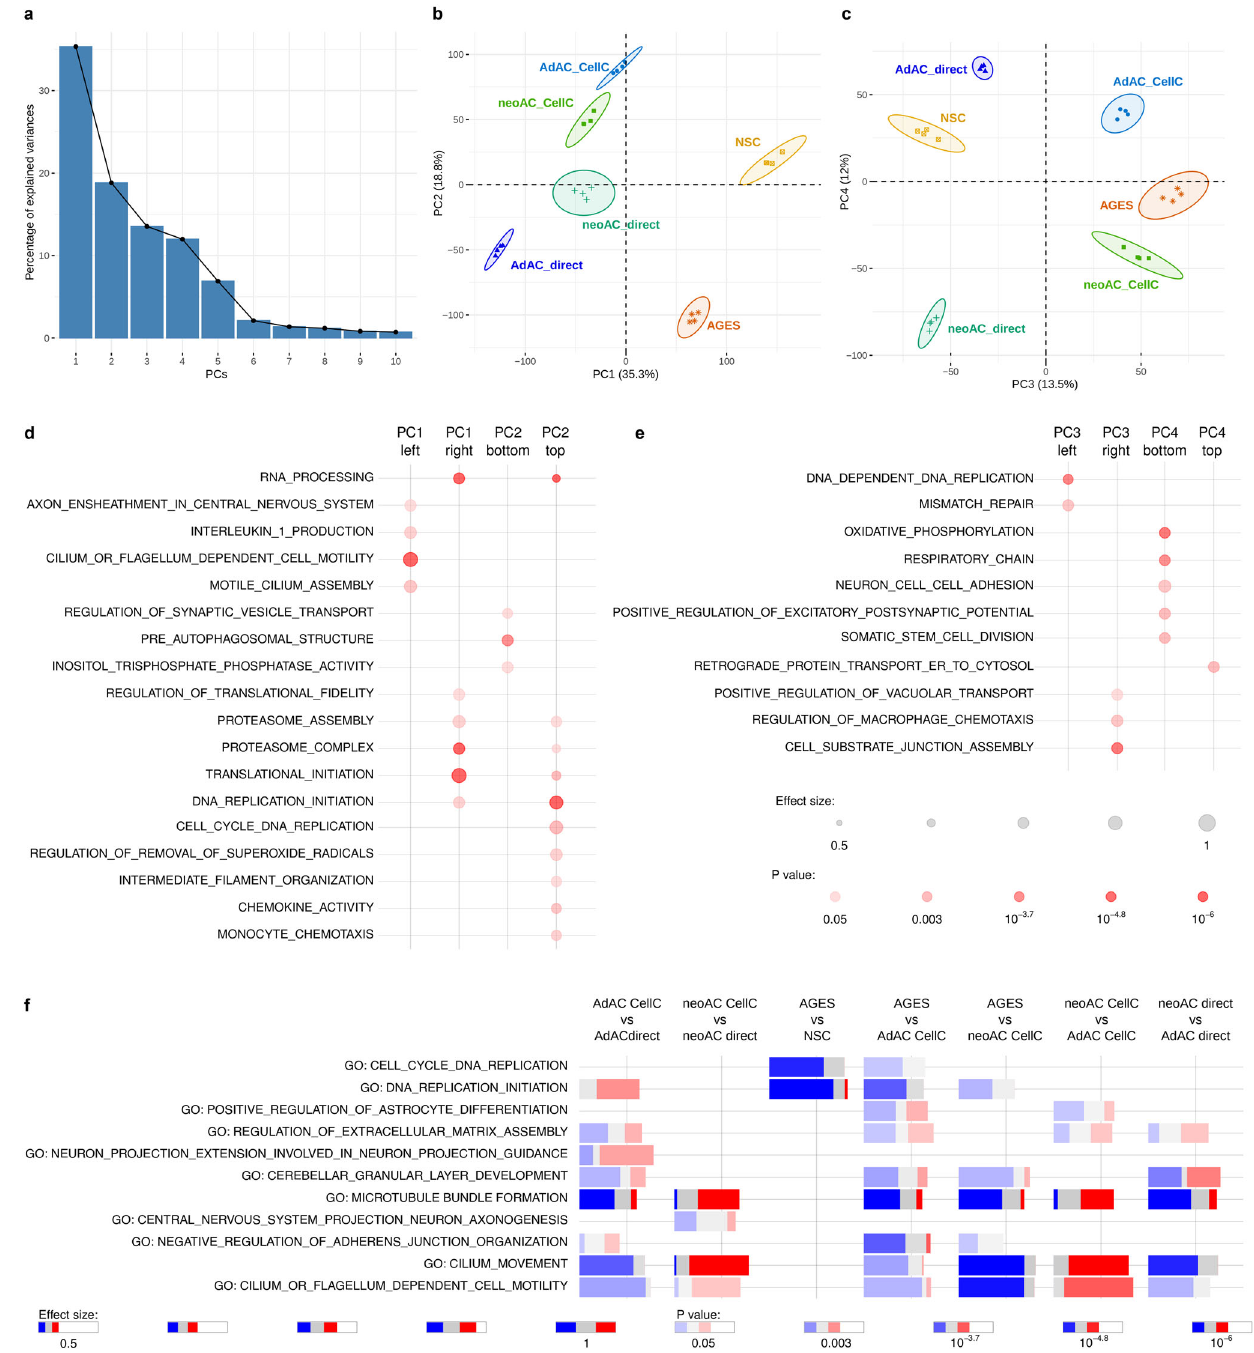
Fig. 3 Transcriptomic pro fi ling of astrocytes reveals major differences introduced by cell culturing, age, and cell origin. RNA-seq was performed on cultured neonatal astrocytes (neoAC CellC; n = 4), directly isolated neonatal astrocytes (neoAC direct; n = 4), cultured adult astrocytes (AdAC CellC; n = 4), directly isolated adult astrocytes (AdAC direct; n = 4), AGES ( n = 4), and NSCs ( n = 4). a – c Principal component analysis (PCA) of RNA-seq results was performed and gene set enrichment analysis was applied to genes ordered by their PCA loadings. The variance explained by the components is shown on the x- and y-axis. d , e Selected gene ontology (GO) terms characterizing each principal component are shown. The size of each dot re fl ects the effect size, while the p value is visualized by color intensity. The effect size is the area under the curve (see Supplementary Fig. 4e). f Differential gene expression-based functional enrichment analysis between cell types was done using the R tmod package. Each bar presents the fraction of signi fi cantly up (red) and downregulated (blue) genes in that particular GO both astrocytes 40 as well as human embryonic and neural stem cells 41,42 and are known to regulate cell division, neurogenesis, cell development, and the response to certain extracellular signals 40,43 – 45 .